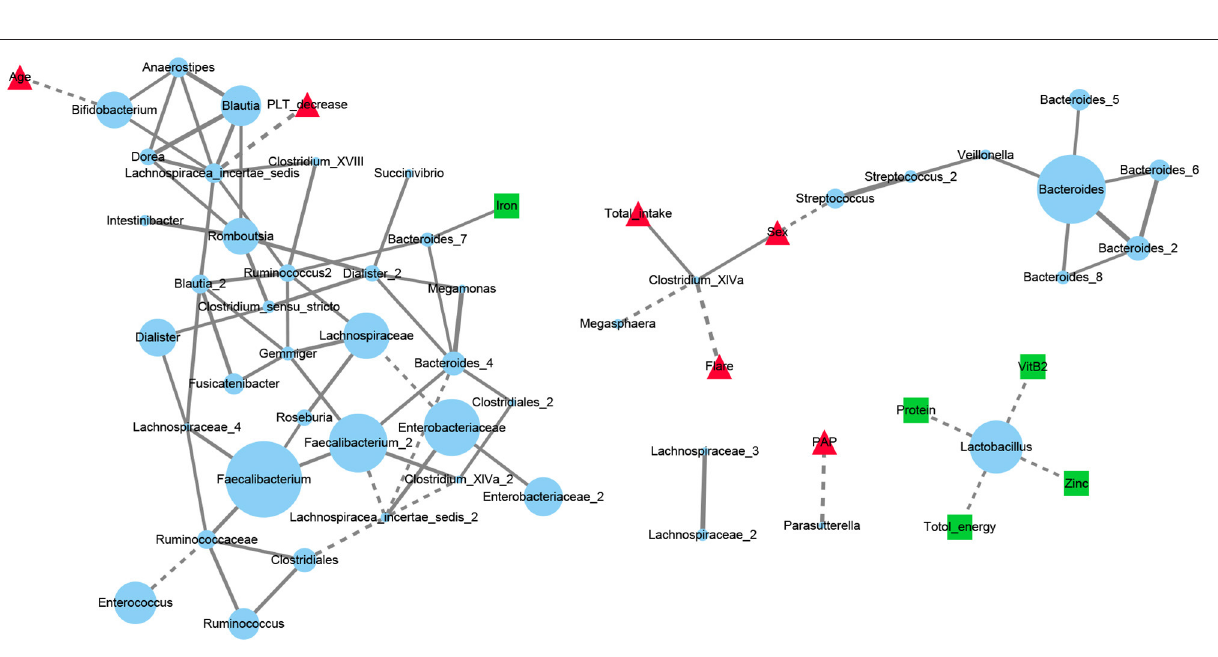
FIGURE 5 | Network analysis of dietary elements, gut microbiota and manifestations of SLE patients. Each blue dot represented for an OTU and its diameter was proportional to the square root of its abundance. Red triangles represented for disease manifestations and green squares for dietary factors. Solid line represented for the significant positive correlations (Spearman r > 0 and FDR adjusted p < 0.05) and dashed for negative correlations (Spearman r < 0 and FDR adjusted p < 0.05). PLT, platelets; Flare: the state of SLE disease flare; PAP, pulmonary artery pressure. its overgrowth in the lower intestine in SLE patients suggests multiple pathobionts, singly or in combination, may contribute flora relocation in SLE (38, 39). Several studies have reported to SLE pathogenesis (19). Second, Streptococcus is enriched in the oral cavity and upper intestinal tract in healthy humans; a higher abundance of fecal Streptococcus associated with